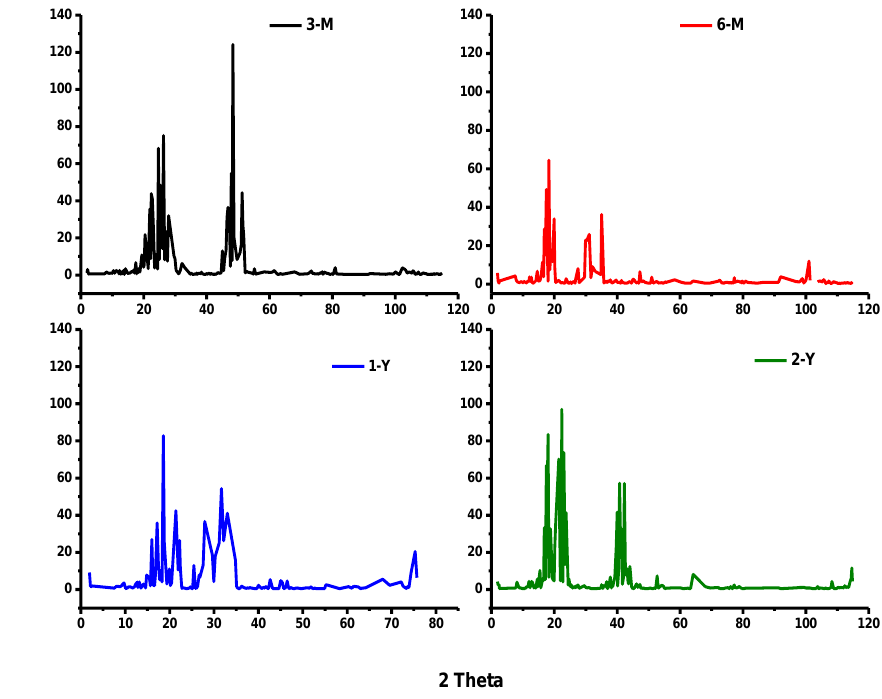
Figure 3. X-ray diffractograms of the beeswax samples with different storage times.